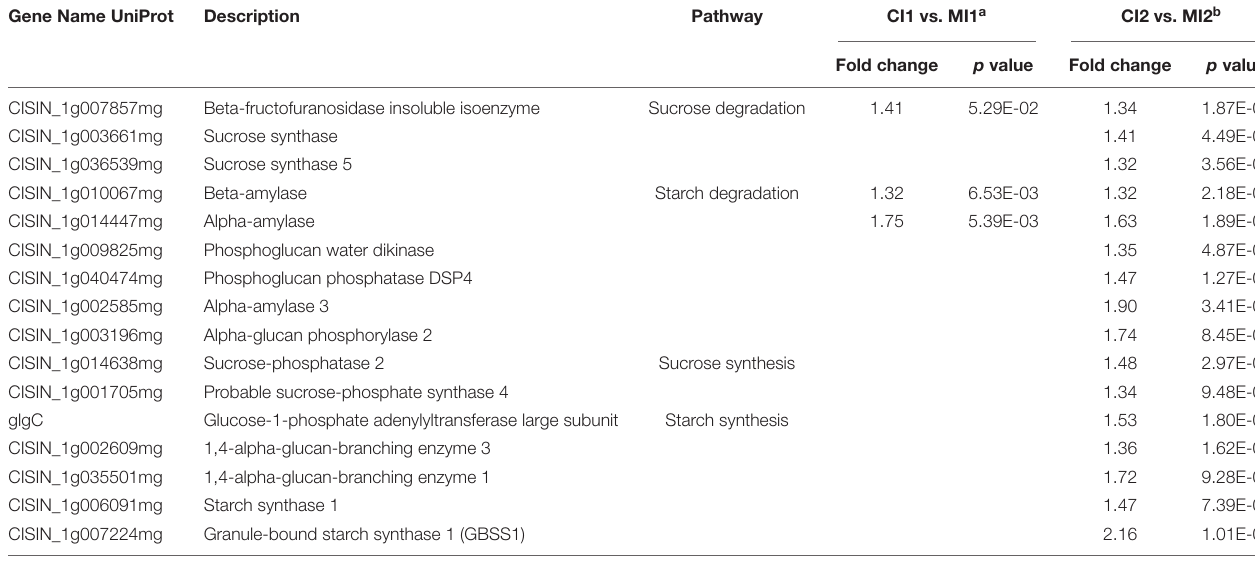
TABLE 2 | Differently accumulated proteins involved in the sucrose and starch metabolism in response to Ca. L. asiaticus infection.